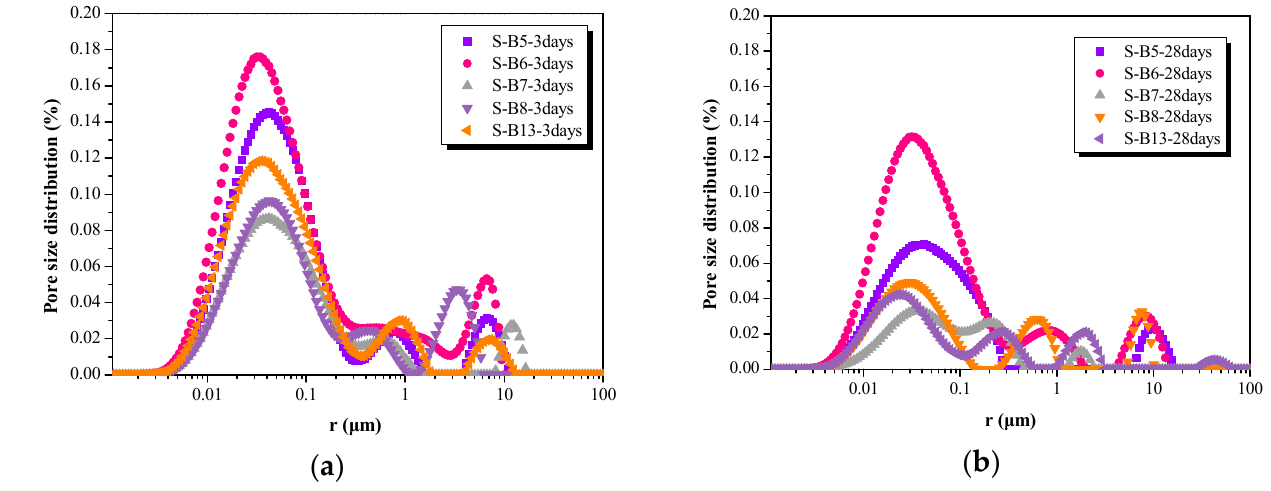
11 of 22 Figure 6. FT-IR spectra of AA-FASM under the different curing conditions. ( a ) Seal curing. ( b ) Dry and water-saturation curing. ( c ) B13. 3.1.6. Pore Structure The pore size distribution curves of AA-FASM samples under the sealed-curing con- ditions are shown in Figure 7. At the curing age of 3 days, the pore size was mostly dis- tributed in the range of 10 and 500 nm regardless of the content of fly ash (B5, B6) or slag (B7, B8 and B13). In contrast, the pore size of B7, B8 and B13 was mainly concentrated in the range of 10~100 nm at 28 days. Table 4 shows the porosity of AA-FASM at different ages adopted with sealed curing. It can be found that the B7 ( W SG = 75%, R A = 45%) cured for 3 and 28 days exhibits the minimum porosity, which was 3.523% and 1.360%, respec-